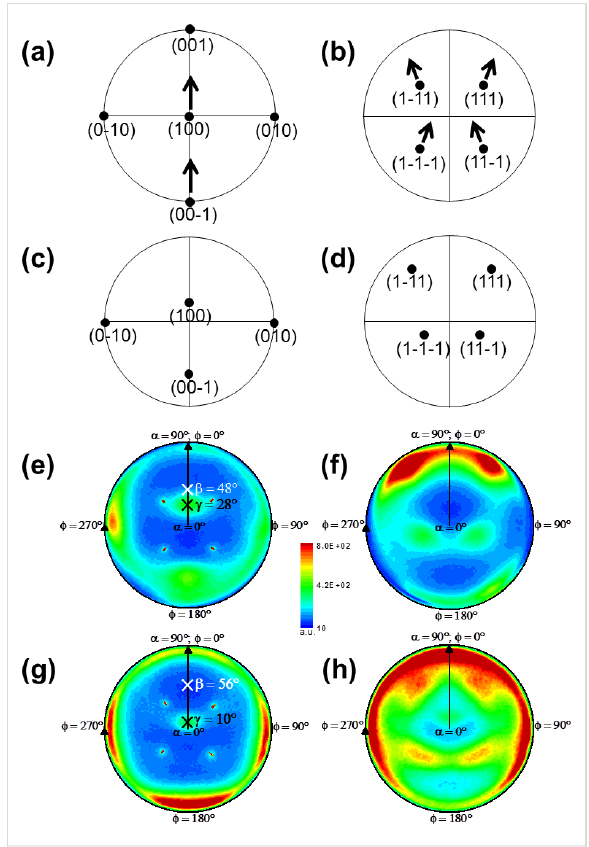
Figure 2: (a) Calculated in-plane pole figures for the cubic Al{200} and (b) Al{111} planes in a vertically ( θ = 0°) deposited thin film. The black arrows illustrate that the pole density maxima move as the substrate is tilted to oblique angles (compare (c)–(h)). (c) Calculated in-plane pole figures for the cubic Al{200} and (d) Al{111} planes in an obliquely ( θ = 82°) deposited thin film. Measured in-plane pole figures for the cubic (e) Al{200} and (f) Al{111} planes in an obliquely ( θ = 82°) deposited thin film at 77 K. (g) Al{200} and (h) Al{111} planes in an obliquely ( θ = 82°) deposited thin film at 300 K. The direction of the crystallites is γ and the tilt angle of the columns is β , both measured with respect to the substrate normal (see (e) and (g)). Intensity (a.u.) is depicted on a linear scale (see scale bar) and applies for all measured in-plane pole figures